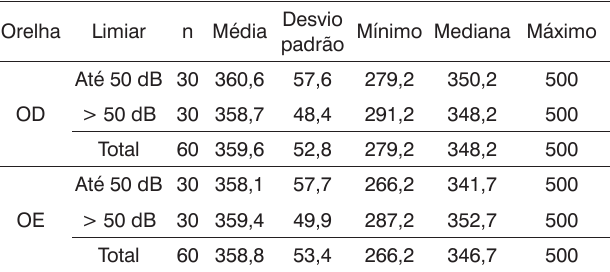
Tabela 4. Estatísticas descritivas para a Latência (ms) no P300 segundo a variável grau de perda, por orelha.